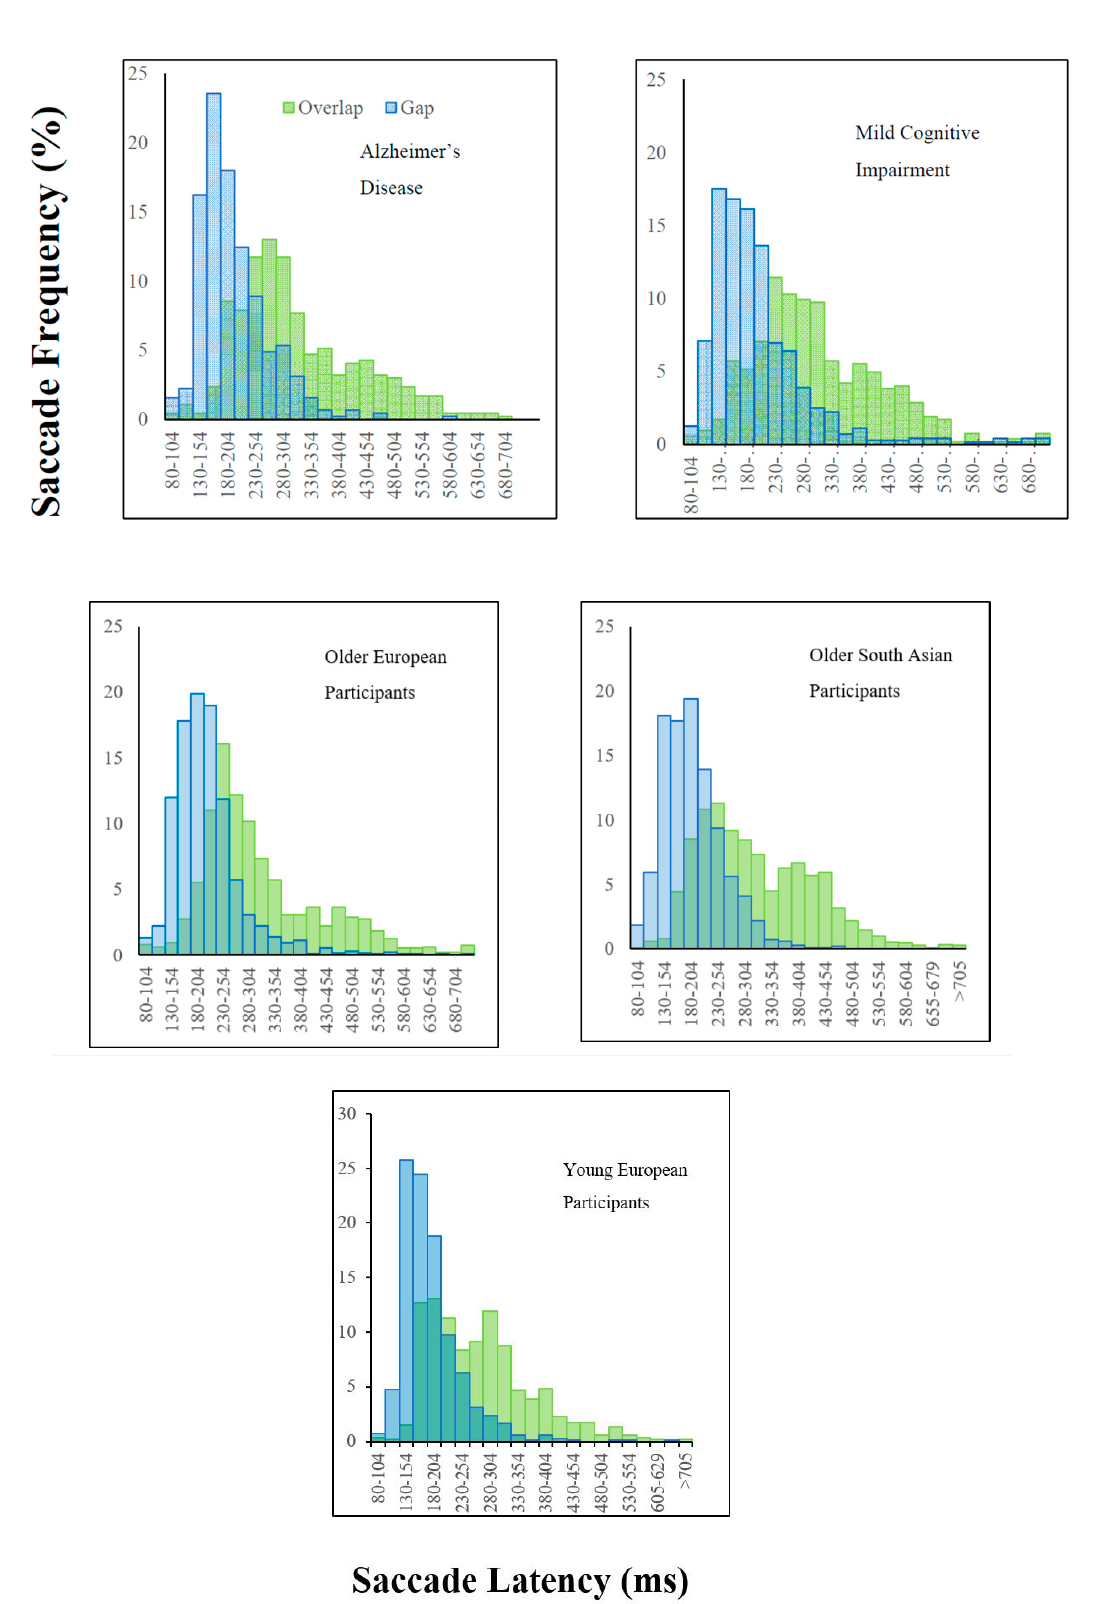
Figure 2. Histograms displaying a shift in the distribution of saccade latencies in the gap condition (blue) compared to the overlap condition (green) for the participant groups: Alzheimer’s disease, mild cognitive impairment, older and younger European participants and older South Asian participants.